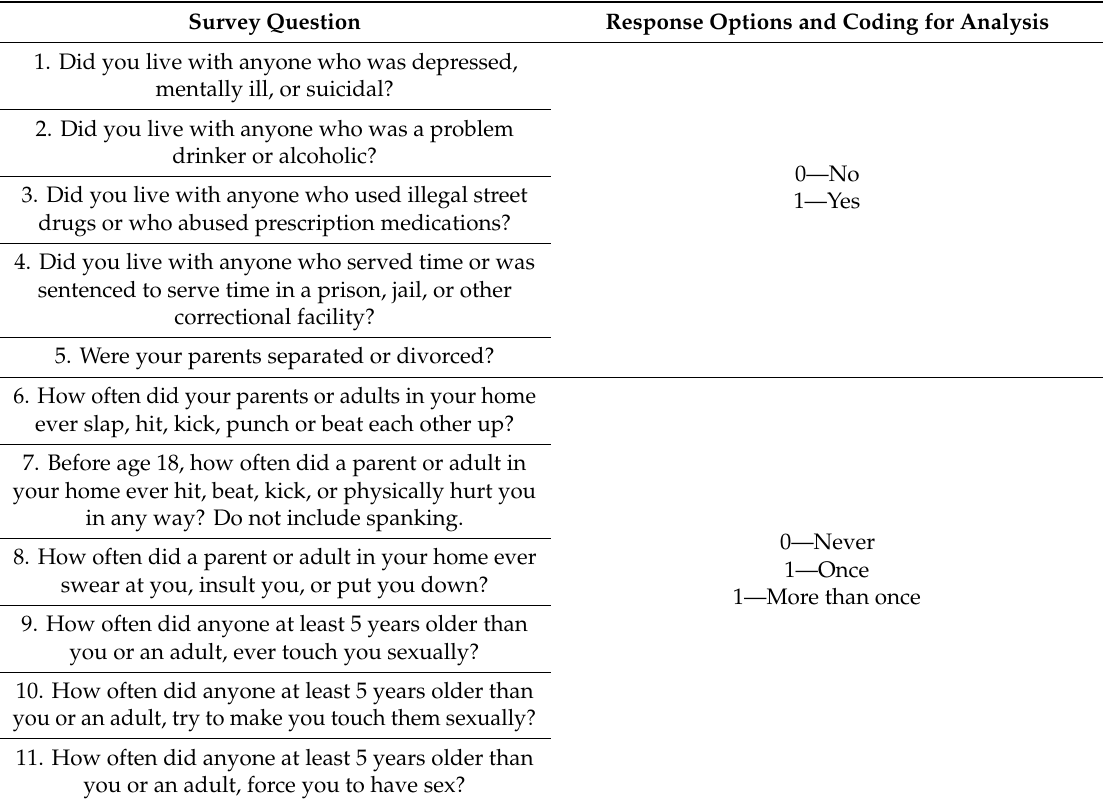
Table 1. Survey questions and response options for the adverse childhood experience module of the Behavioral Risk Factor Surveillance System,